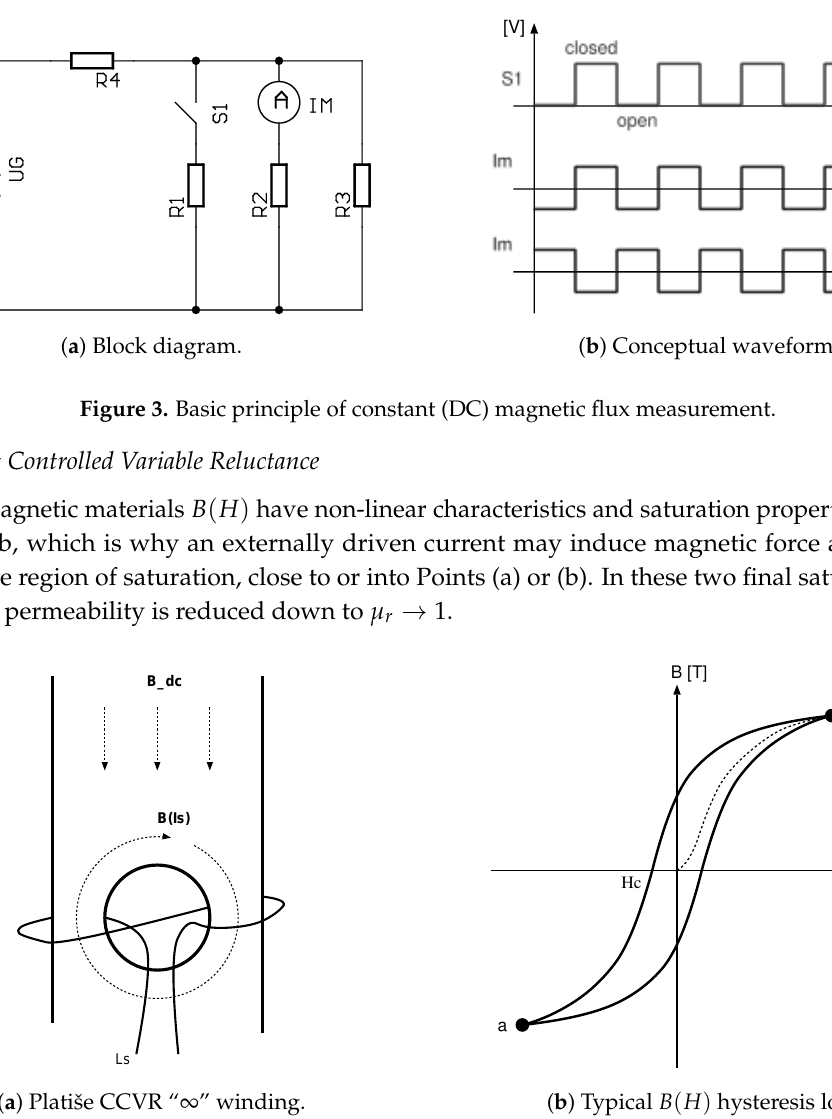
Figure 4. Current controlled variable